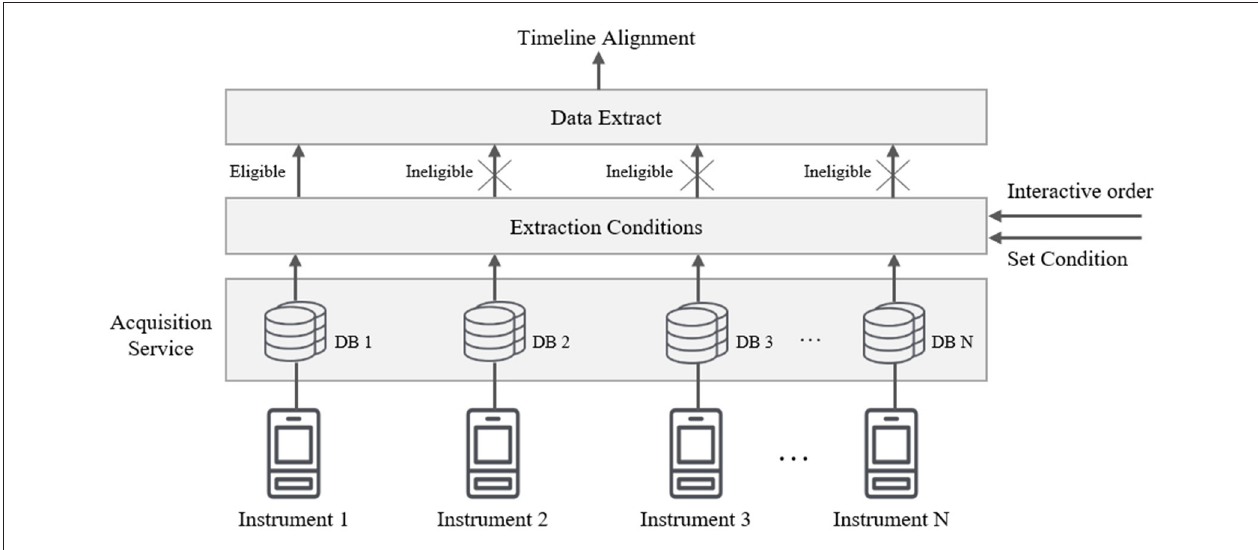
FIGURE 5 | The flow of acquisition coordination.